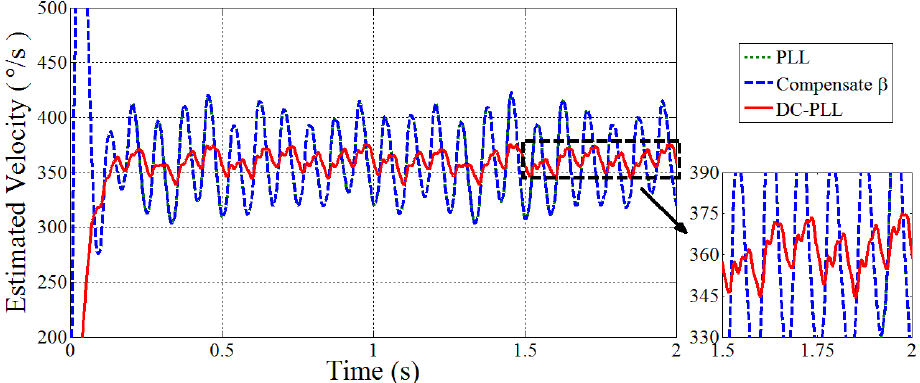
Figure 14. Phase detector error at fixed speed in experiment.